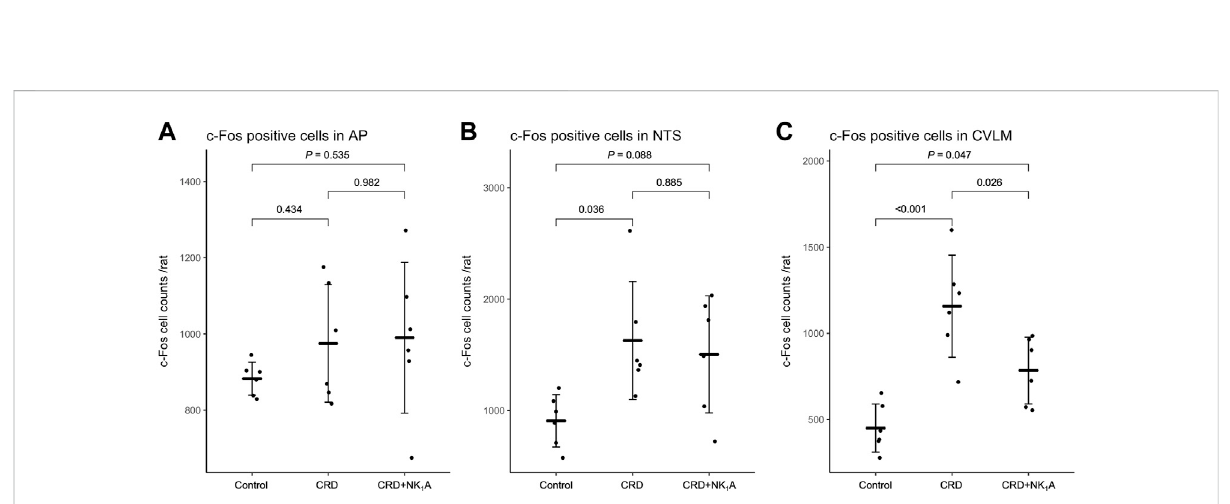
FIGURE 5 The number of c-Fos immunoreactive cells in AP (A) , NTS (B) and CVLM (C) from the groups stimulated by colorectal distension (Group CRD and CRD + NK 1 A) and non-stimulated (Control) rats. Group CRD received saline, and Group CRD + NK 1 A received fosaprepitant (30 mg/kg) intraperitoneally before the colorectal distension. Data are expressed as mean ± standard deviation. AP: the area postrema. NTS, the nucleus of the solitary tract; CVLM, the caudal ventrolateral medulla; p values: compared among groups using Tukey ’ s multiple comparison